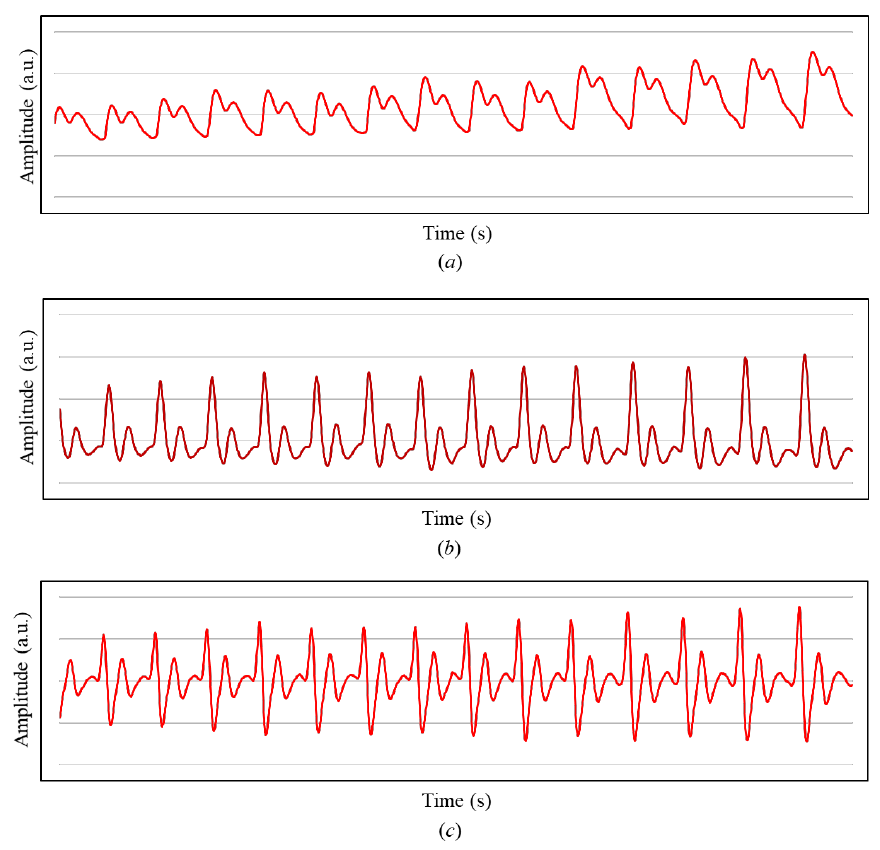
Figure 1. Photoplethysmography (PPG) waveform and its derivative waveforms: ( a ) PPG waveform, ( b ) first-derivative PPG waveform, and ( c ) second-derivative PPG waveform.